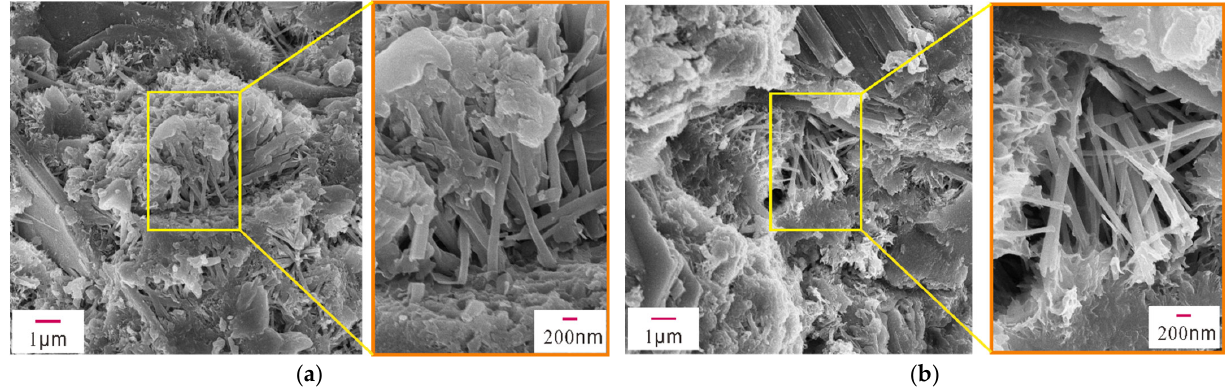
Figure 8. SEM images of sample 10N. ( a ) Partial SEM image of sample 10N, ( b ) Partial SEM image of sample 10N.